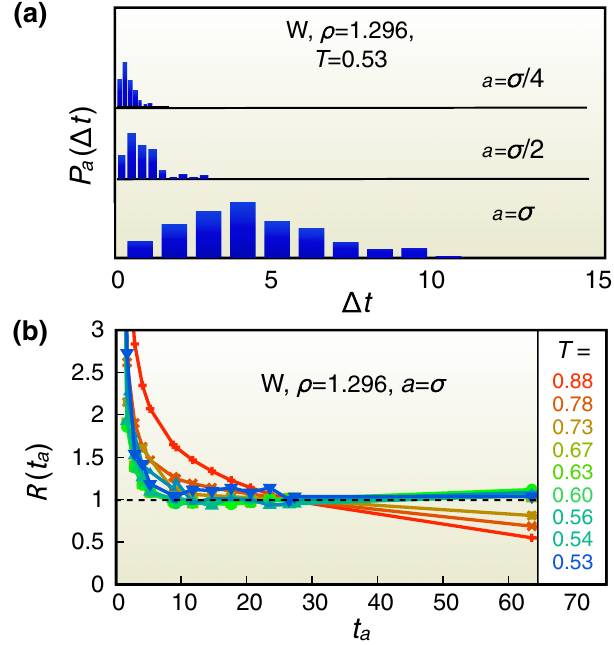
FIG. 2. Excitation dynamics exhibits separation of time scales with instanton times and plateau times. (a) The probability distribution of the instanton time, P a ð (cid:1) t Þ , for the W system (see Table I) at the lowest equilibrated temperature for three different displacement lengths, a ¼ (cid:3)= 4 , (cid:3)= 2 and (cid:3) . (b) The mean value of the rate function R ð t a Þ , demonstrating that a plateau value exists for T smaller than the onset temperature, T . The particular system considered here is the W model at the o ’ 0 : 88 . Lines in panel (b) are density (cid:8) ¼ 1 : 296 , where T o drawn through data points as guides to the